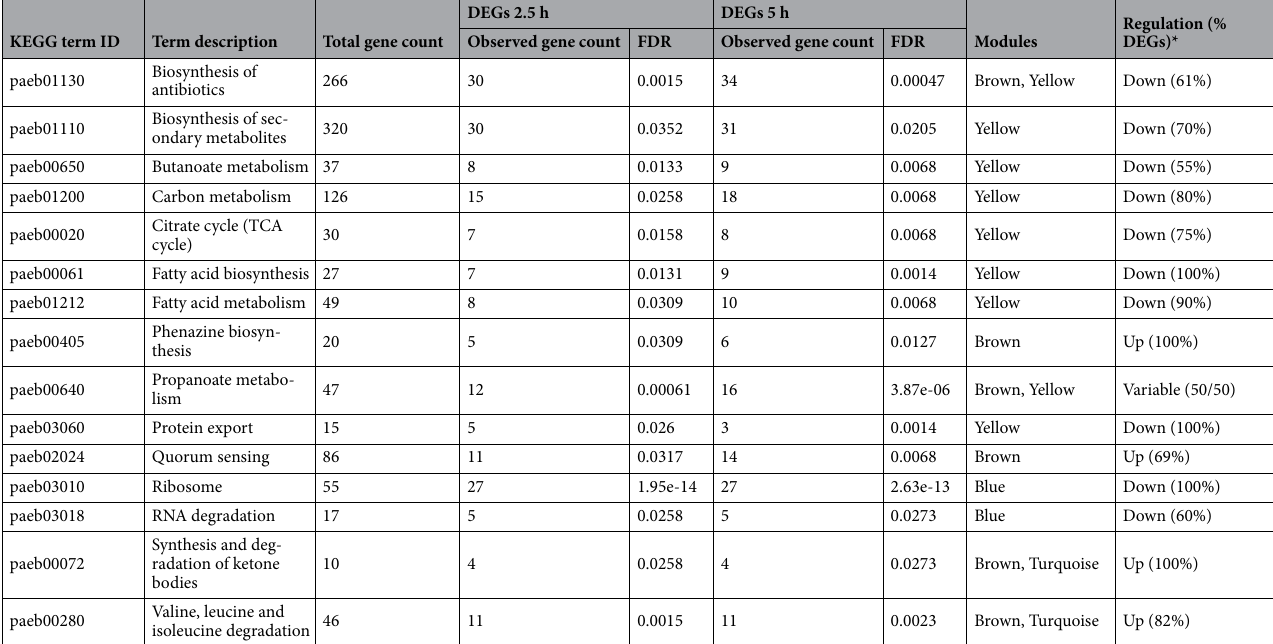
Table 3. Pathways related to DEGs network of PaeAG1 exposed to ciprofloxacin, according to KEGG annotation. Annotation of modules of co-expressed genes and the general regulation are also included. *Based on logFC of DEGs at both times 2.5 and 5